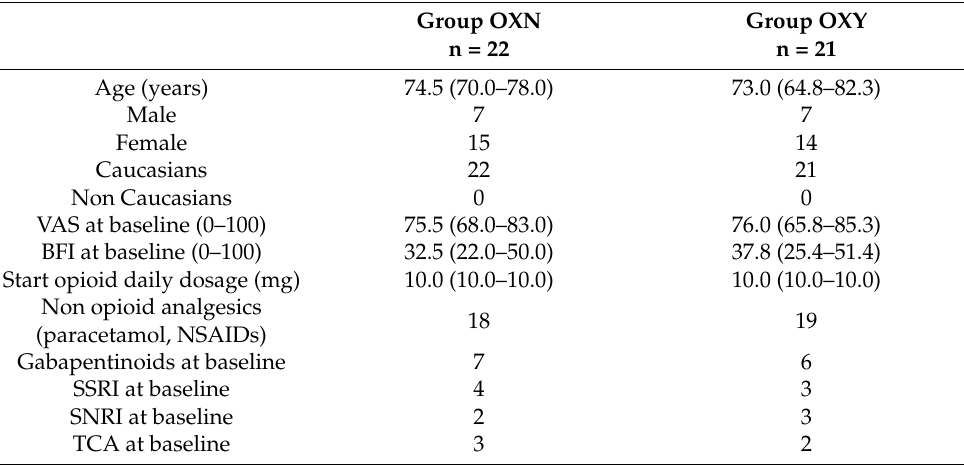
Table 1. Values are expressed as median [IQR, 25–75] for quantitative variables and as number of patients for qualitative variables. Group OXY, oxycodone; Group OXN, oxycodone + naloxone. SSRI, Selective Serotonin Reuptake Inhibitors, SNRI, Selective Noradrenaline Reuptake Inhibitors, TCA Tricyclic Acids. The baseline BFI score difference between the two groups was not statistically